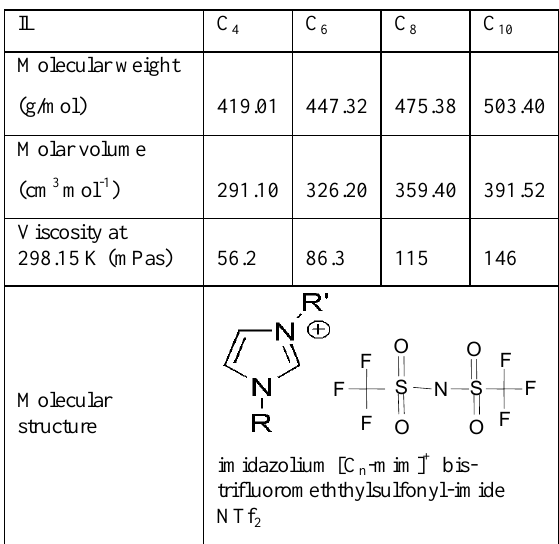
Table 4.1 Physical-chemical properties of pure ILs [C n - mim][NTf 2 ] used in this